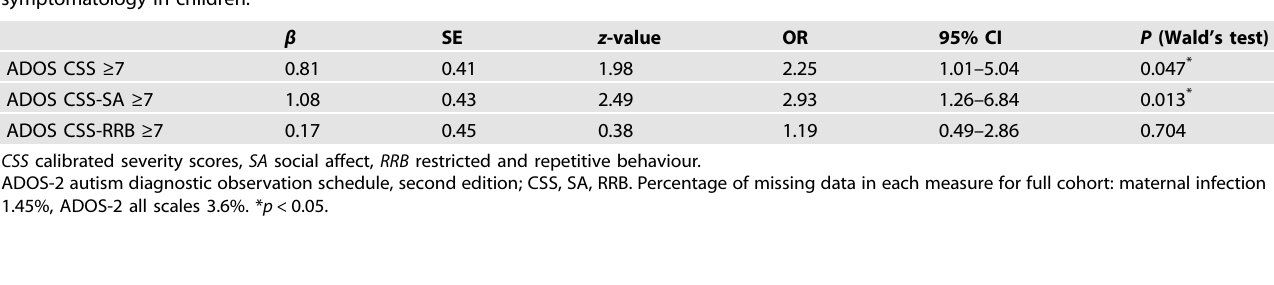
Table 3. Demographic characteristics of children with ASD and comorbid eczema, non-atopic or comorbid asthma/allergies ( n = 67).